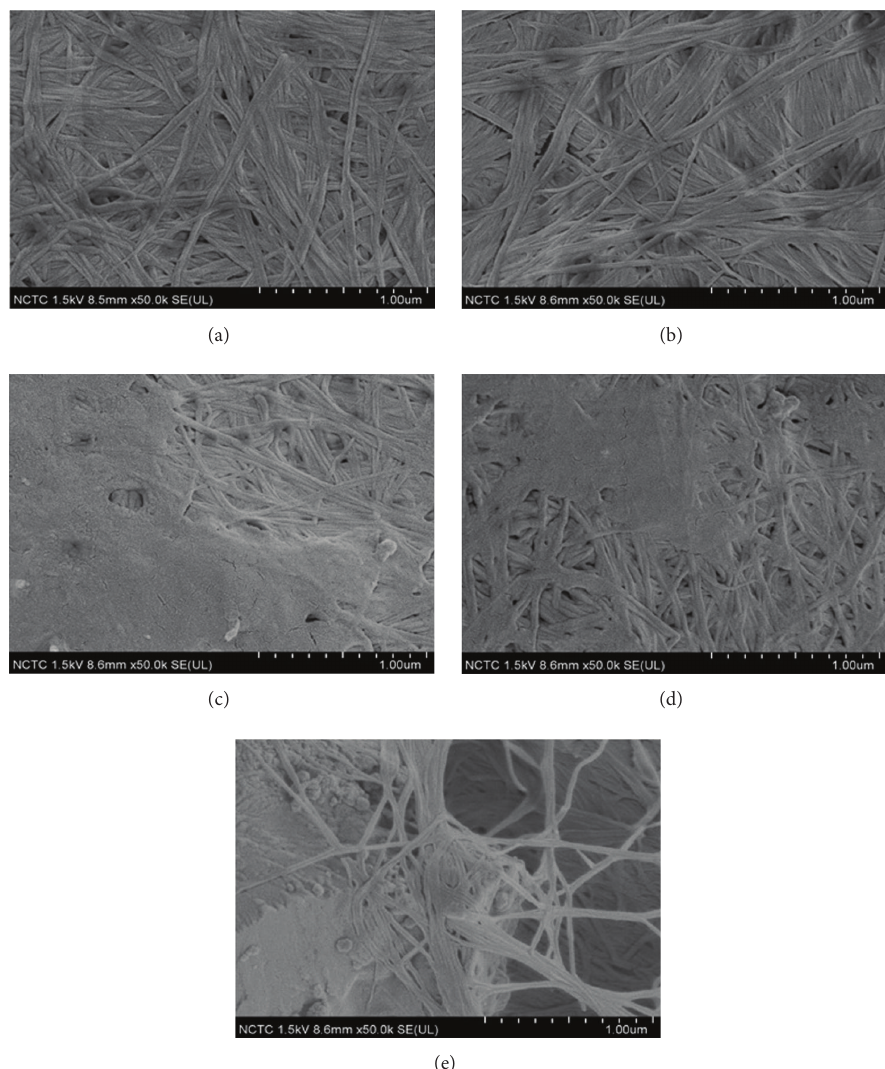
Figure 5: Morphological properties of eggshell and bacterial cellulose composite membrane (a) neat bacterial cellulose. (b) 1: 0.5 weight ratio of bacterial cellulose and eggshell. (c) 1:1 weight ratio of bacterial cellulose and eggshell. (d) 1:2 weight ratio of bacterial cellulose and eggshell. (e) 1 :5 weight ratio of bacterial cellulose and